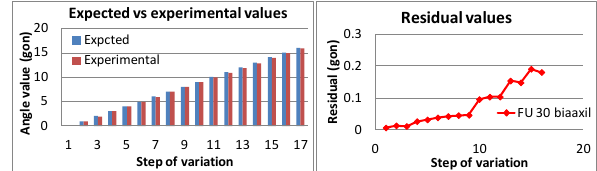
Figure 12. Tilt values for biaxial mode. Experimental values (left) - residual